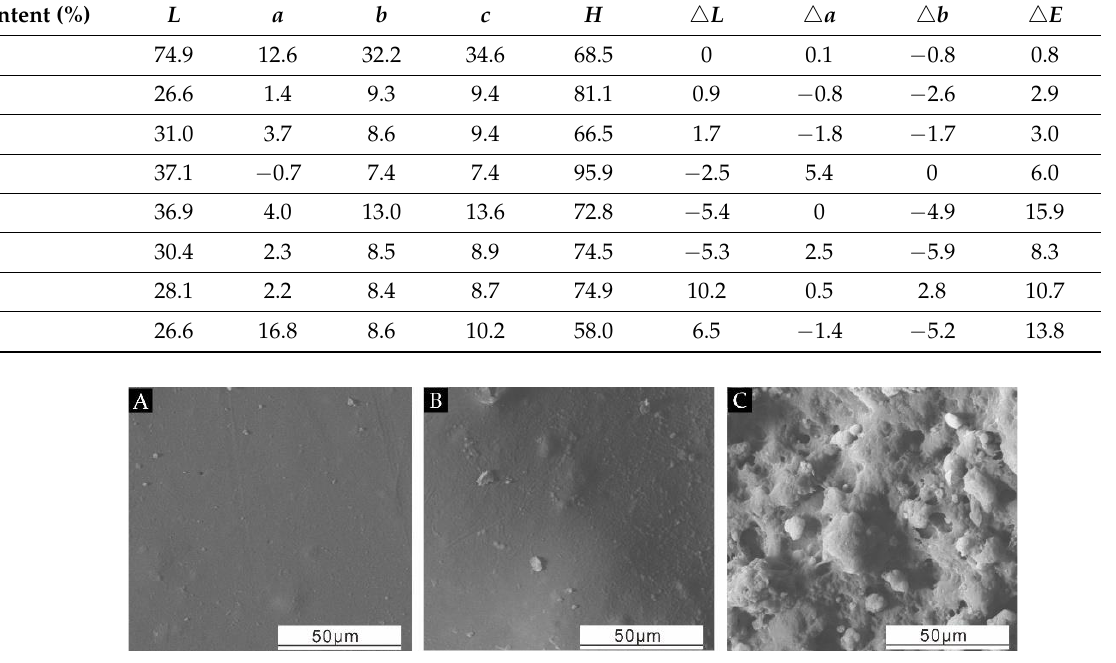
Figure 4. SEM images of coating with the microcapsule core-wall ratio of 0.67: ( A ) no microcapsules; ( B ) the microcapsule content is 7.0%; ( C ) the microcapsule content is 16.0%.